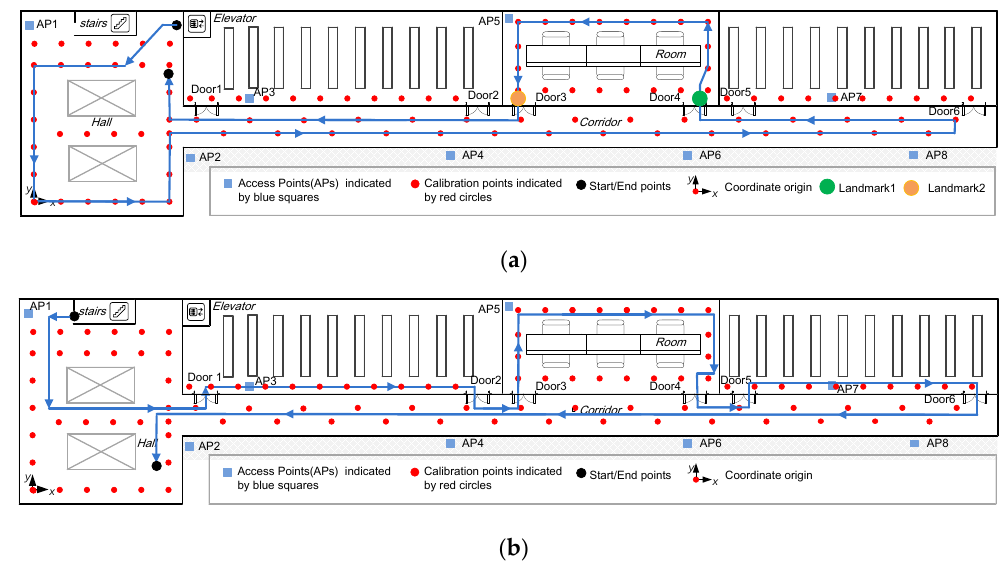
Figure 4. Experimental environment and the true walking path: ( a ) path one; ( b ) path two.